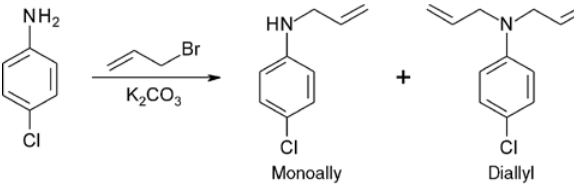
Figure 1: Scheme of synthesis of N -allyl-4-chloroaniline and the byproduct N , N -diallyl-4-chloroaniline.